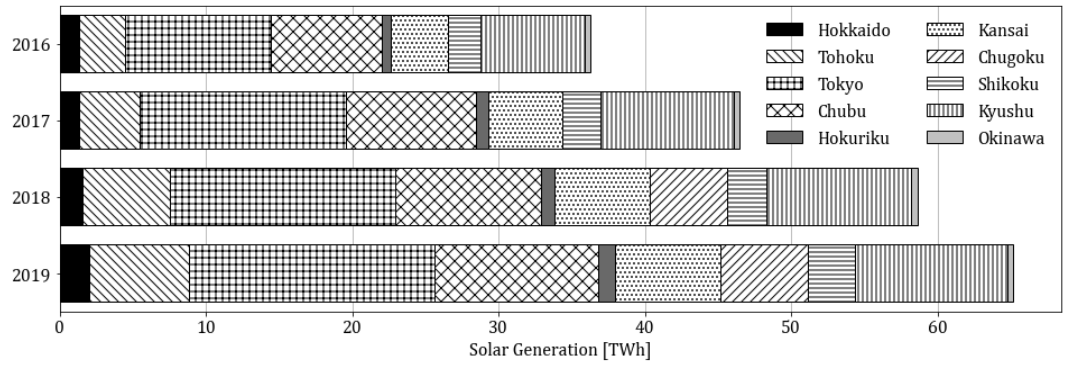
Figure 6. Annual PV electricity generation (TWh) for each region between 2016 and